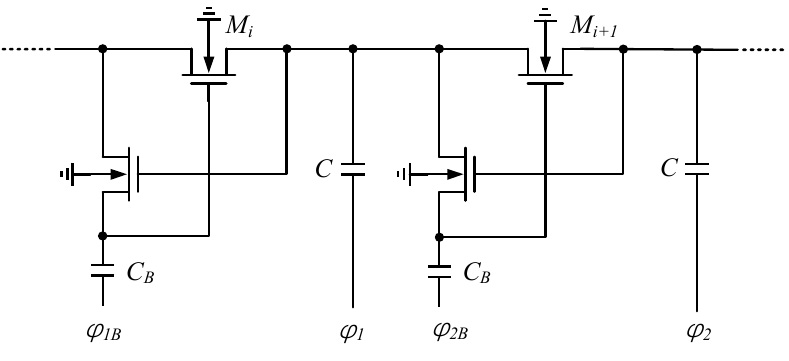
Figure 3. Gate biasing CP.